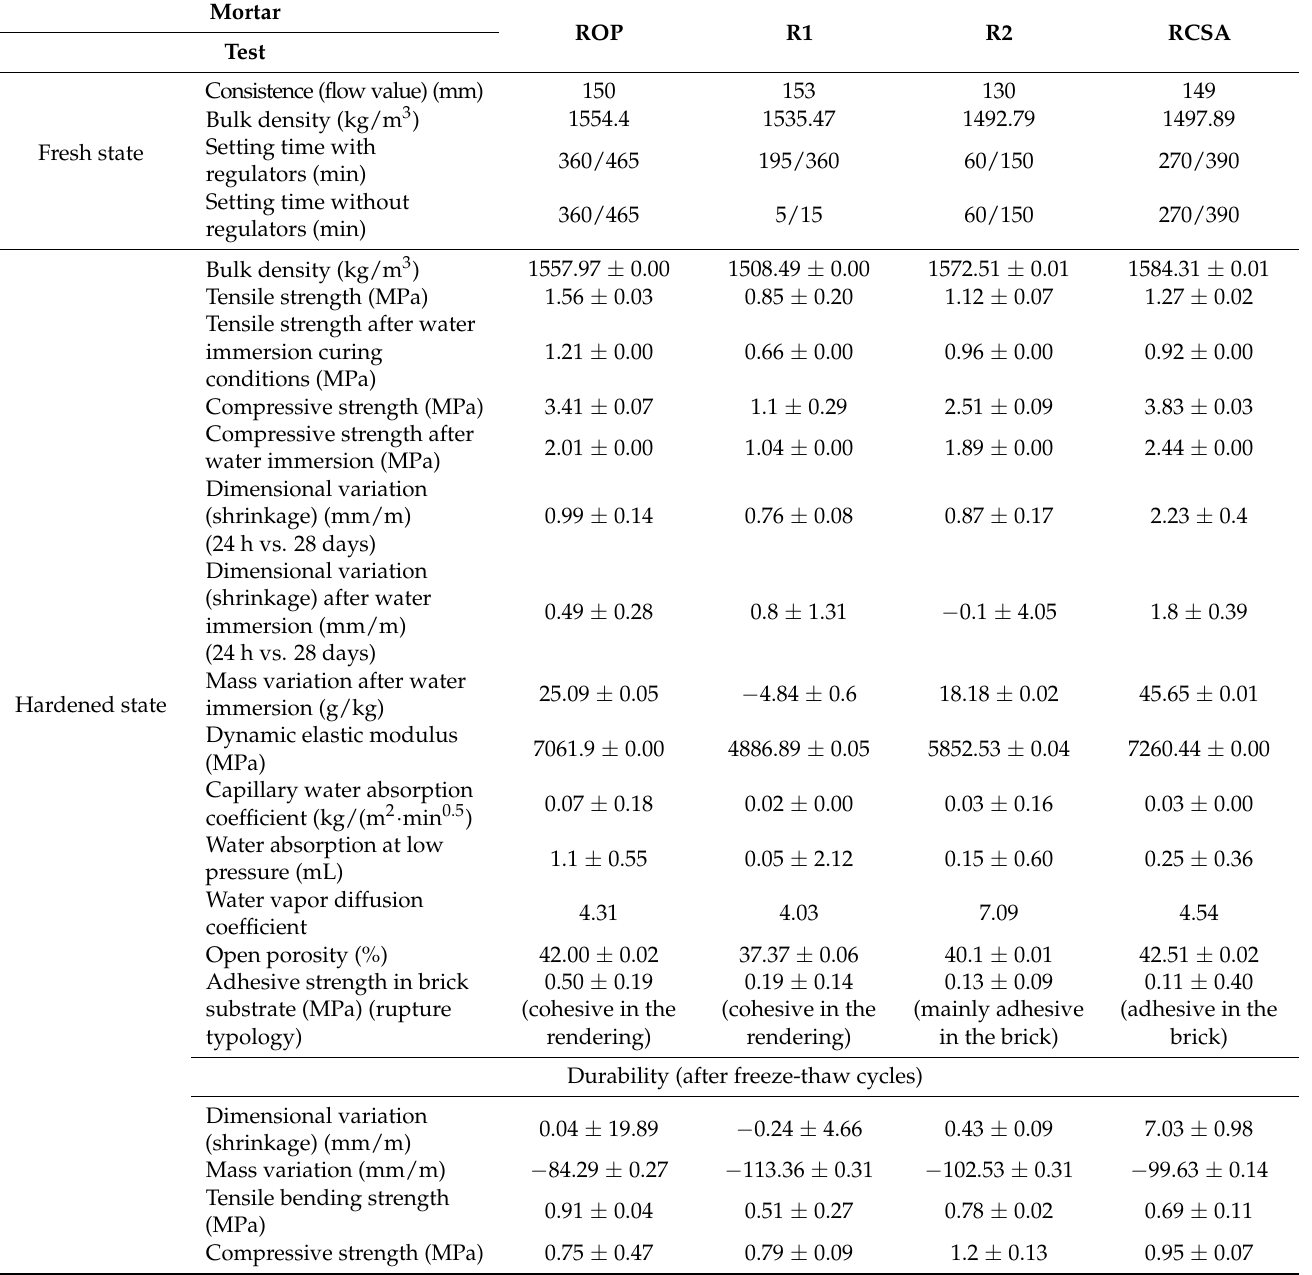
Table 6. Physical-mechanical and durability results of the rendering mortar.